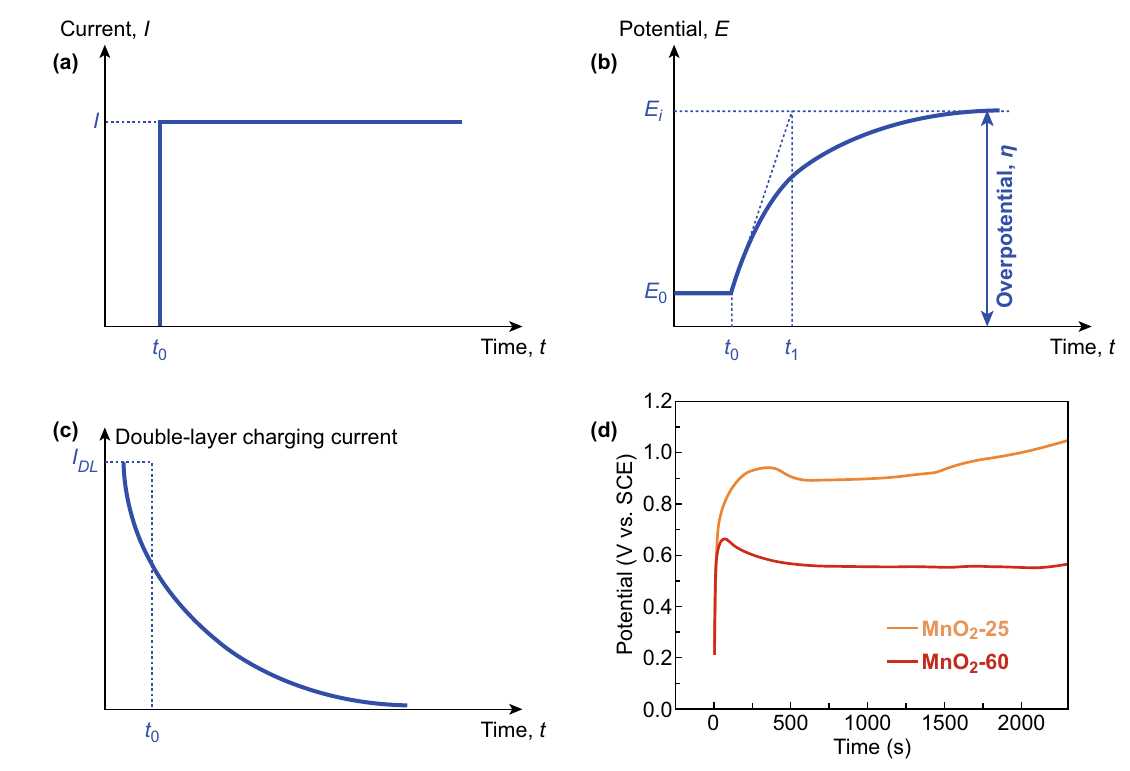
Fig. 4 a Constant current applied during a galvanostatic deposition; t 0 represents the moment when current is applied. b Potential response as a function of time in a galvanostatic deposition; E 0 and E i are the equilibrium potential and maximal potential of a working electrode during galva‑ nostatic deposition, respectively. c Double‑layer charging current ( I DL ) decays exponentially with time. d Time evolutions of the potential during galvanostatic depositions of MnO